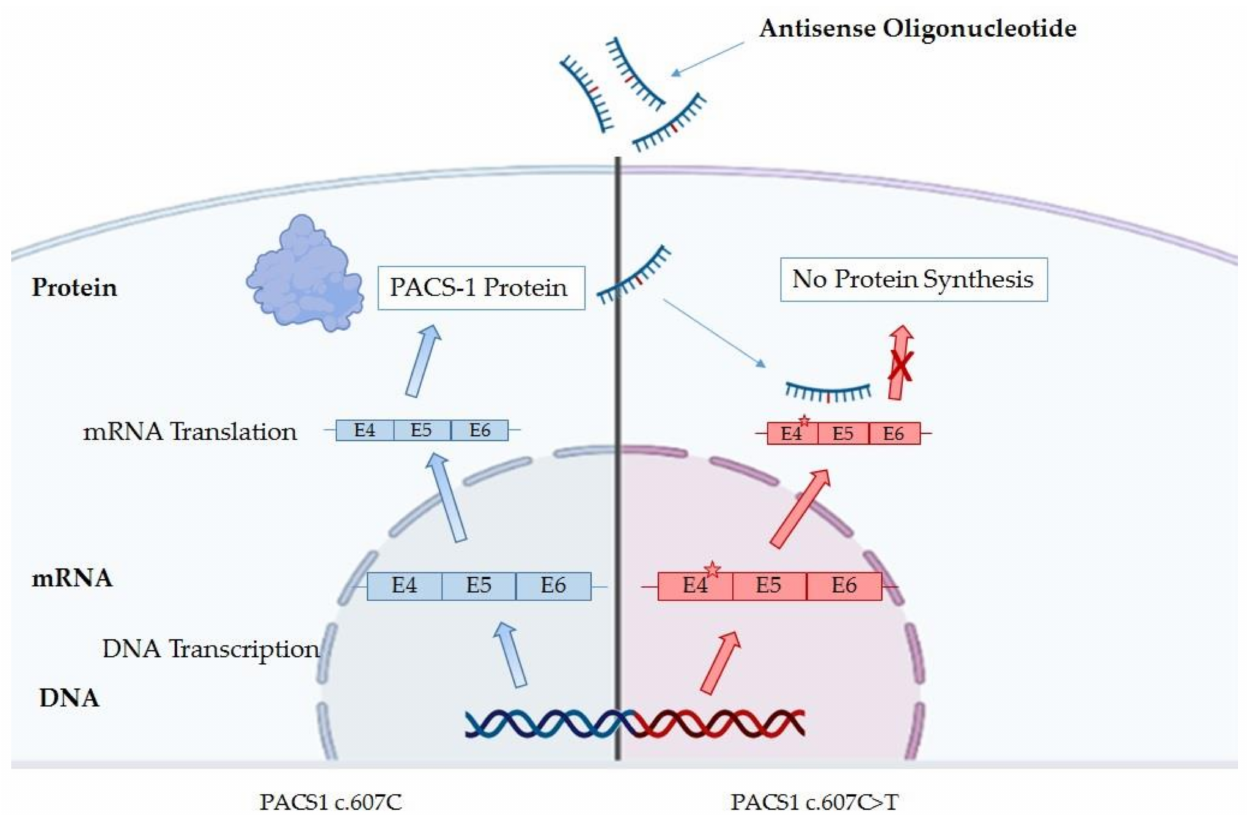
Figure 3. Schematic mechanism of antisense oligonucleotides (ASOs) therapy in order to avoid the translation of the mutant PACS-1